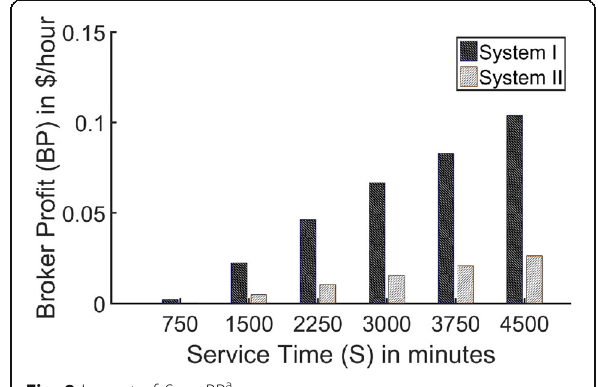
Fig. 8 Impact of S on BP a Fig. 6 Impact of f on UC